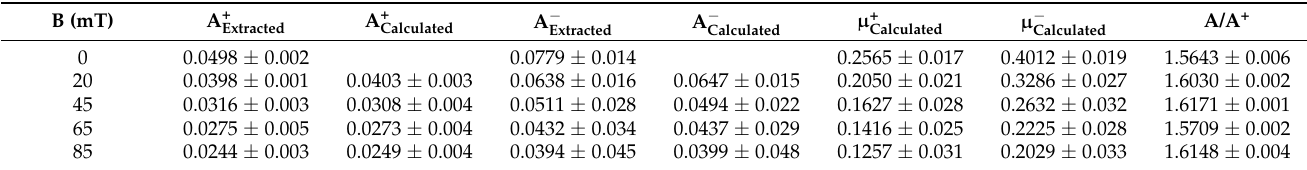
Table 2. The extracted and the calculated values of A and the mobility of charge carries µ at different magnetic field B for positive and negative corona